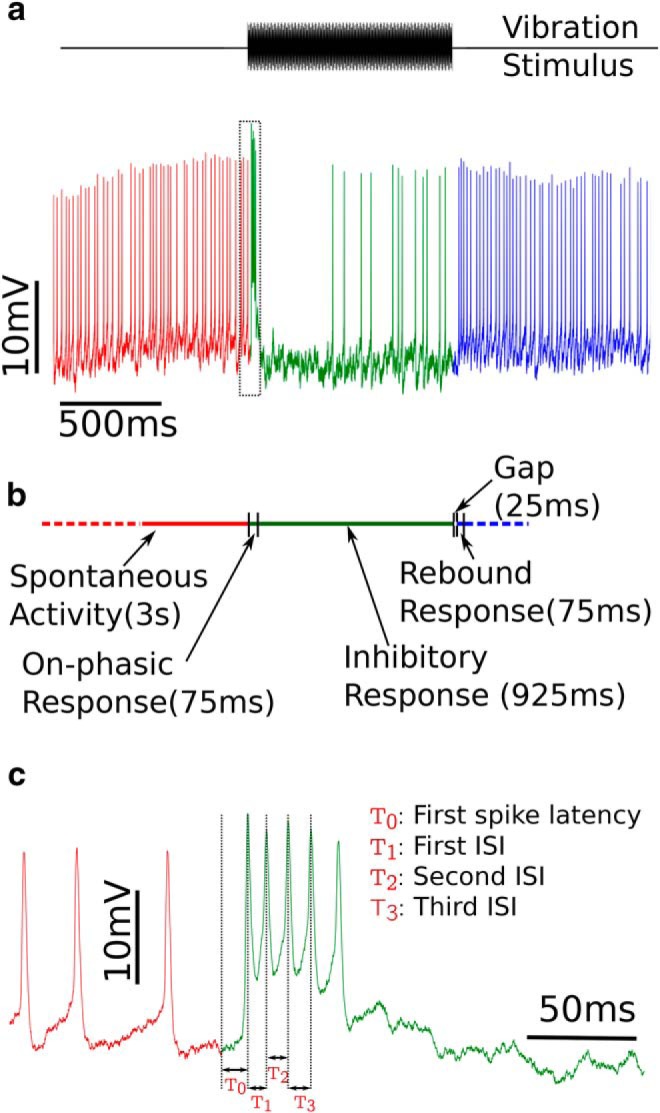
Definition of activity periods and spike timing features of electrophysiological responses. a, An example response of DL-Int-1 to 1 s long vibration stimulus of 265 Hz. Activity before stimulus is colored in red, activity during stimulus in green and activity after stimulus in blue. b, The definitions of the four activity periods used for analyzing electrophysiological properties of DL-Int-1. c, The trace contained in the dotted rectangle in a is magnified and the four spike timing features, T0, T1, T2, and T3 are defined on it.